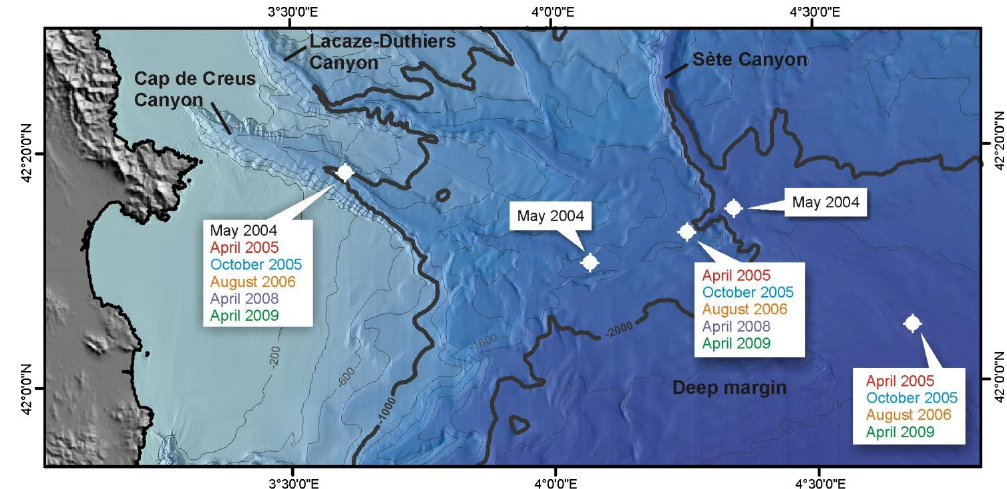
Fig. 1. Location of sampling areas in the Cap de Creus Canyon and the deep margin. Dots include neighboring stations visited during different sampling periods. Geographical coordinates of sampling stations are detailed in Table 1.